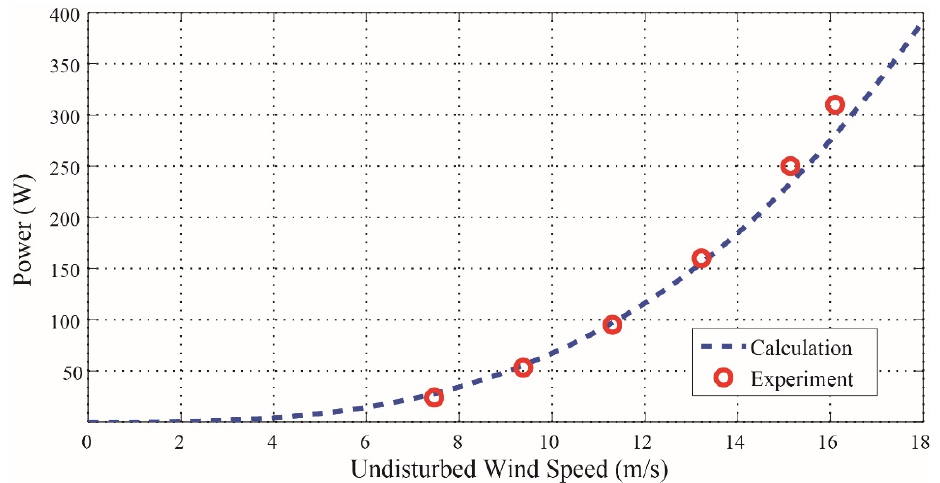
Figure 17. Experimental setup of the performance evaluation test: ( a ) schematic diagram; and ( b ) photo of the experimental setup.